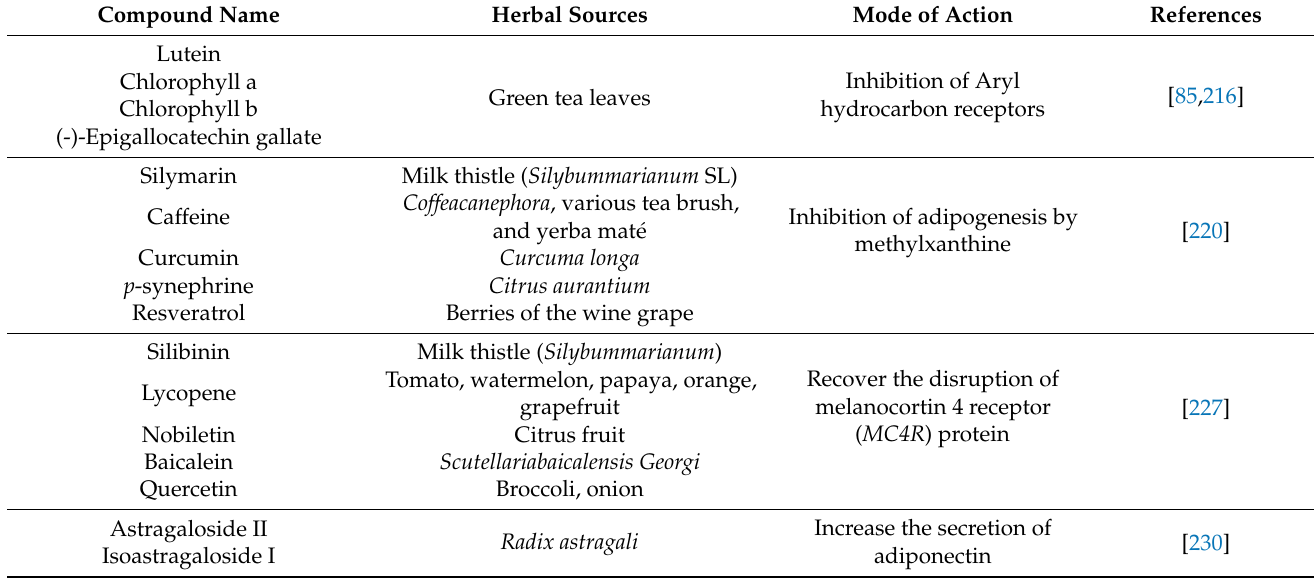
Table 2. Herbal therapeutics with their mode of action against